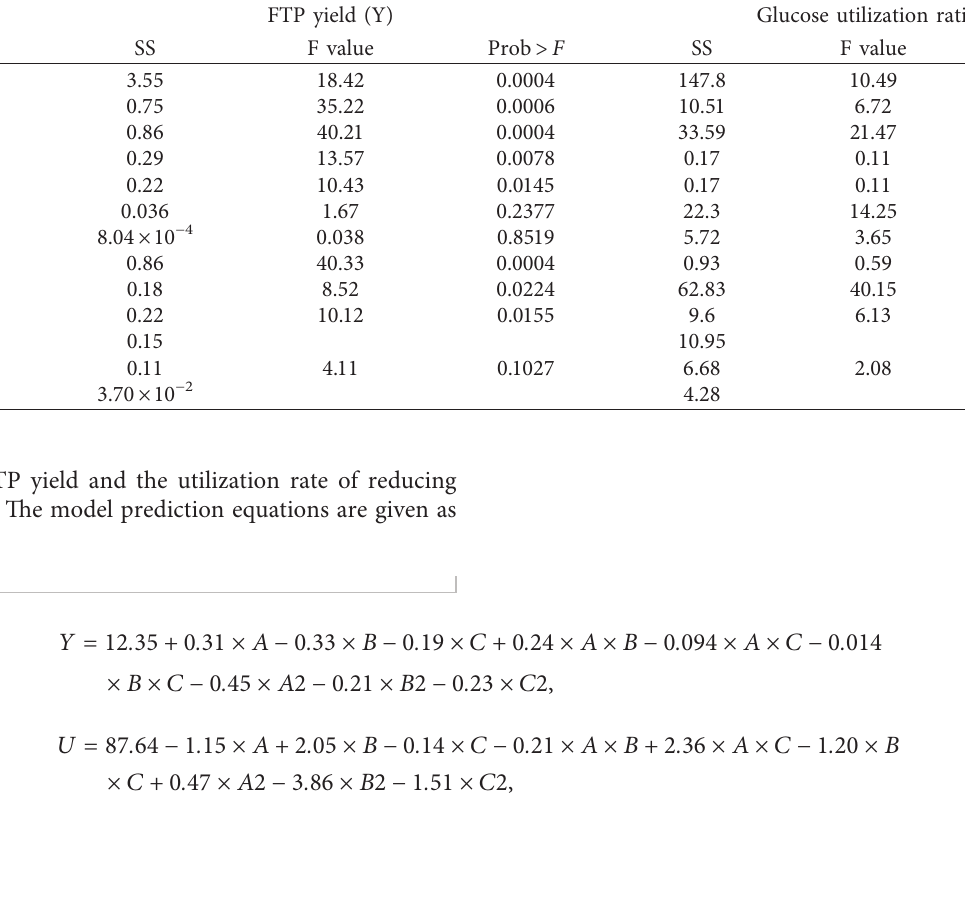
Table 8: ANOVA for the response surface polynomial model of all independent